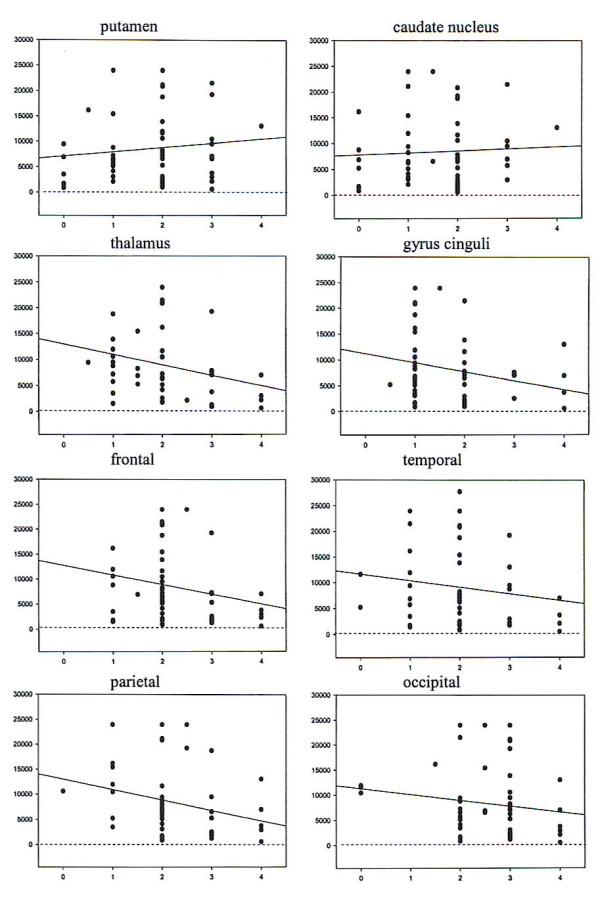
Correlation between tau CSF levels and degree of neuronal loss in various brain areas. (- - - - - - cut-off 195 pg/ml).